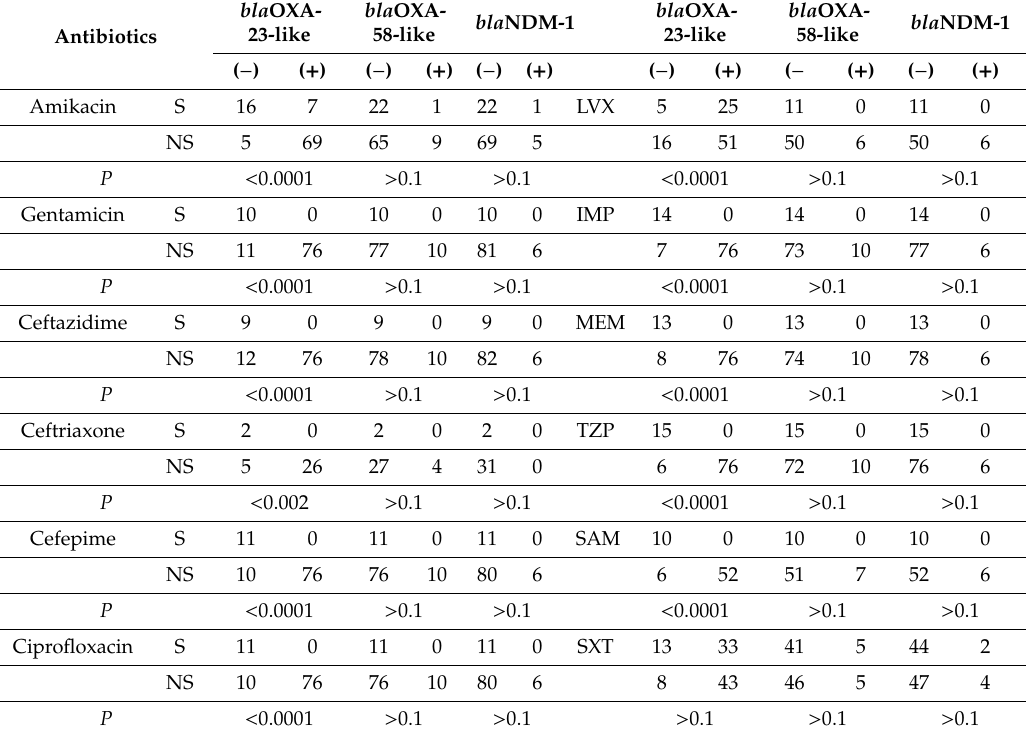
Table 3. Relationship between gene types and antibiotic